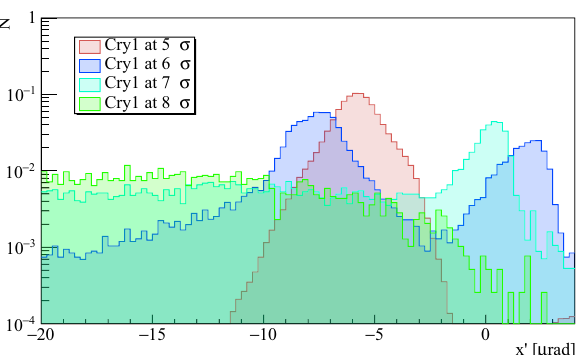
Fig. 7 Angular distribution (in the machine reference frame) of impacting protons for different settings of the Cry 1 in IR3